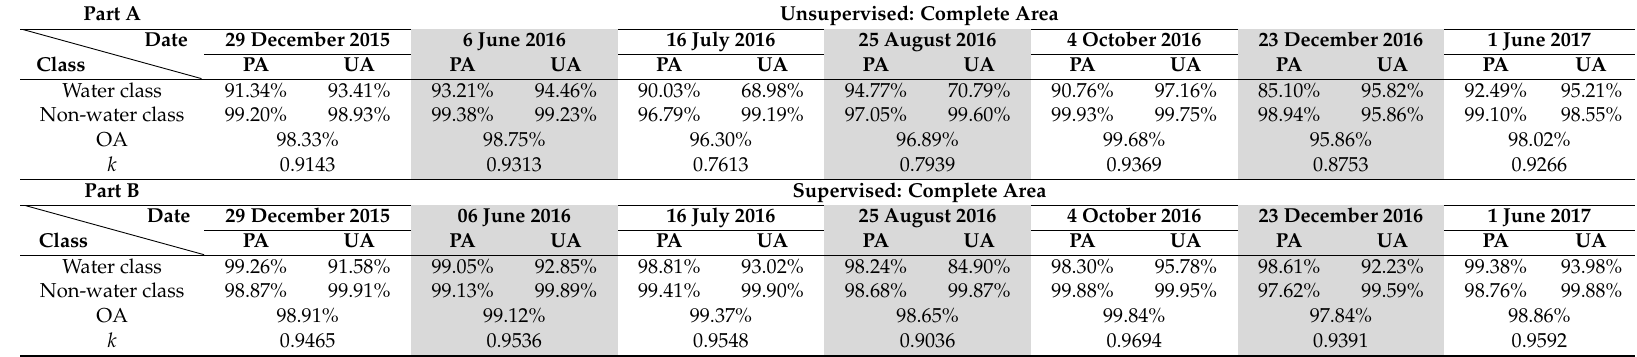
Table 4. Part A and Part B show for the complete area the accuracy assessment results for the unsupervised and supervised approaches, respectively.